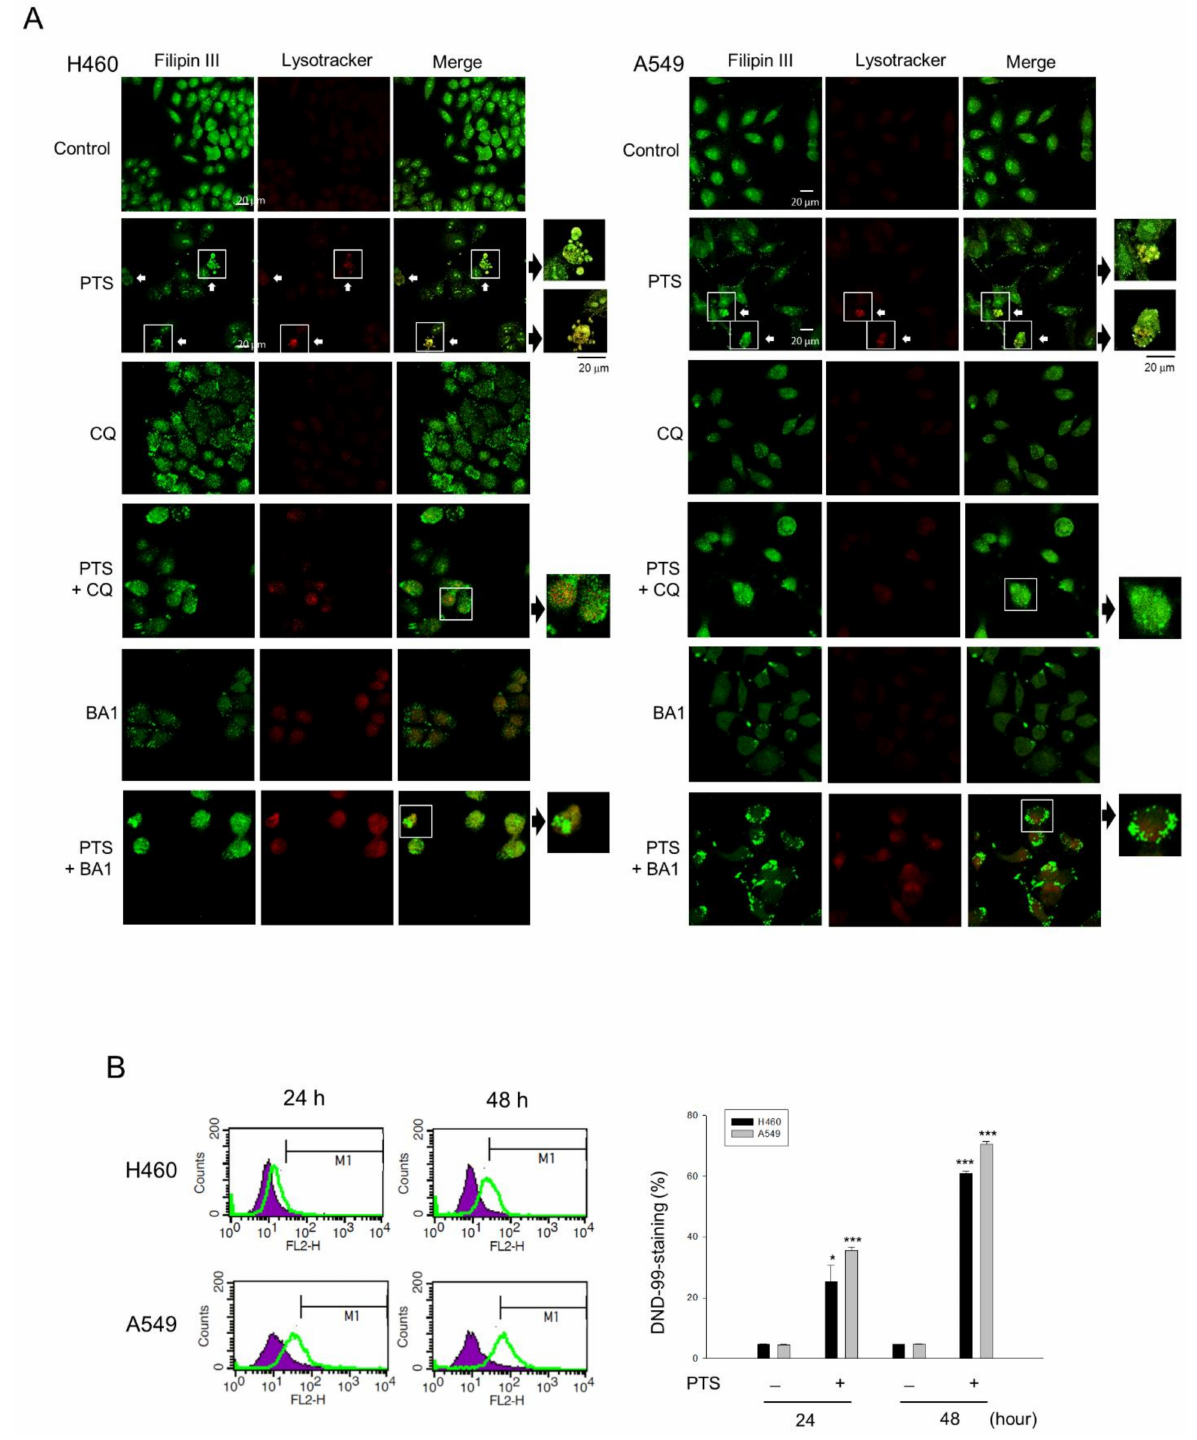
Figure 5. Effect of para -toluenesulfonamide on cholesterol distribution. ( A ) NCI-H460 and A549 cells were incubated in the absence or presence of the indicated agent ( para -toluenesulfonamide, 6 mM; CQ, 50 µ M chloroquine; BA1, 0.1 µ M bafilomycin A1) for 24 h. Cellular cholesterol distribution was determined by Filipin III staining (green fluorescence) coupled with Lysotracker DND-99 immunofluorescence staining (red fluorescence). The arrow indicates the plasma membrane cholesterol. The yellow fluorescence indicates the co-localization of cholesterol and lysosomes. ( B ) The cells were incubated in the absence or presence of 6 mM PTS for 24 or 48 h. The cells were harvested for the detection of lysosome formation using flow cytometric analysis of LysoTracker Red-DND-99 staining. The data are expressed as mean ± SEM of three independent determinations. * p < 0.05 and *** p < 0.001 compared with the